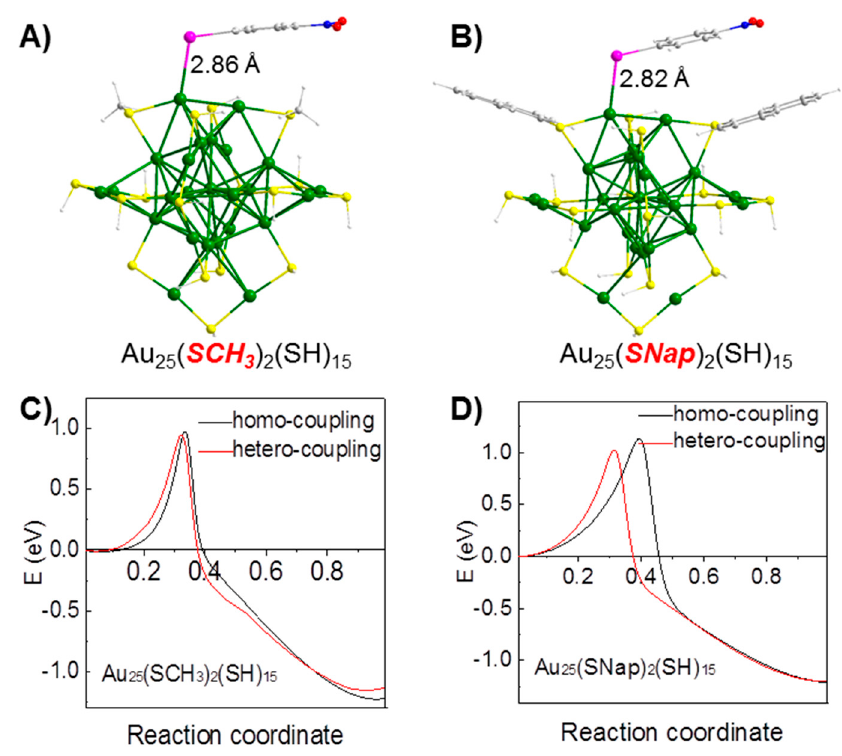
Figure 5. Interaction of 4-NO 2 C 6 H 4 I with the exposed Au atoms on the Au 25 (SCH 3 ) 2 (SH) 15 ( A ) and Au 25 (SNap) 2 (SH) 15 ( B ). Energy vs. reaction coordinate with “-SCH 3 ” ( C ) and “-SNap” ligands ( D ) during the homo- and hetero-coupling reactions. Reproduced with permission from [46]. American Chemical Society, 2016.